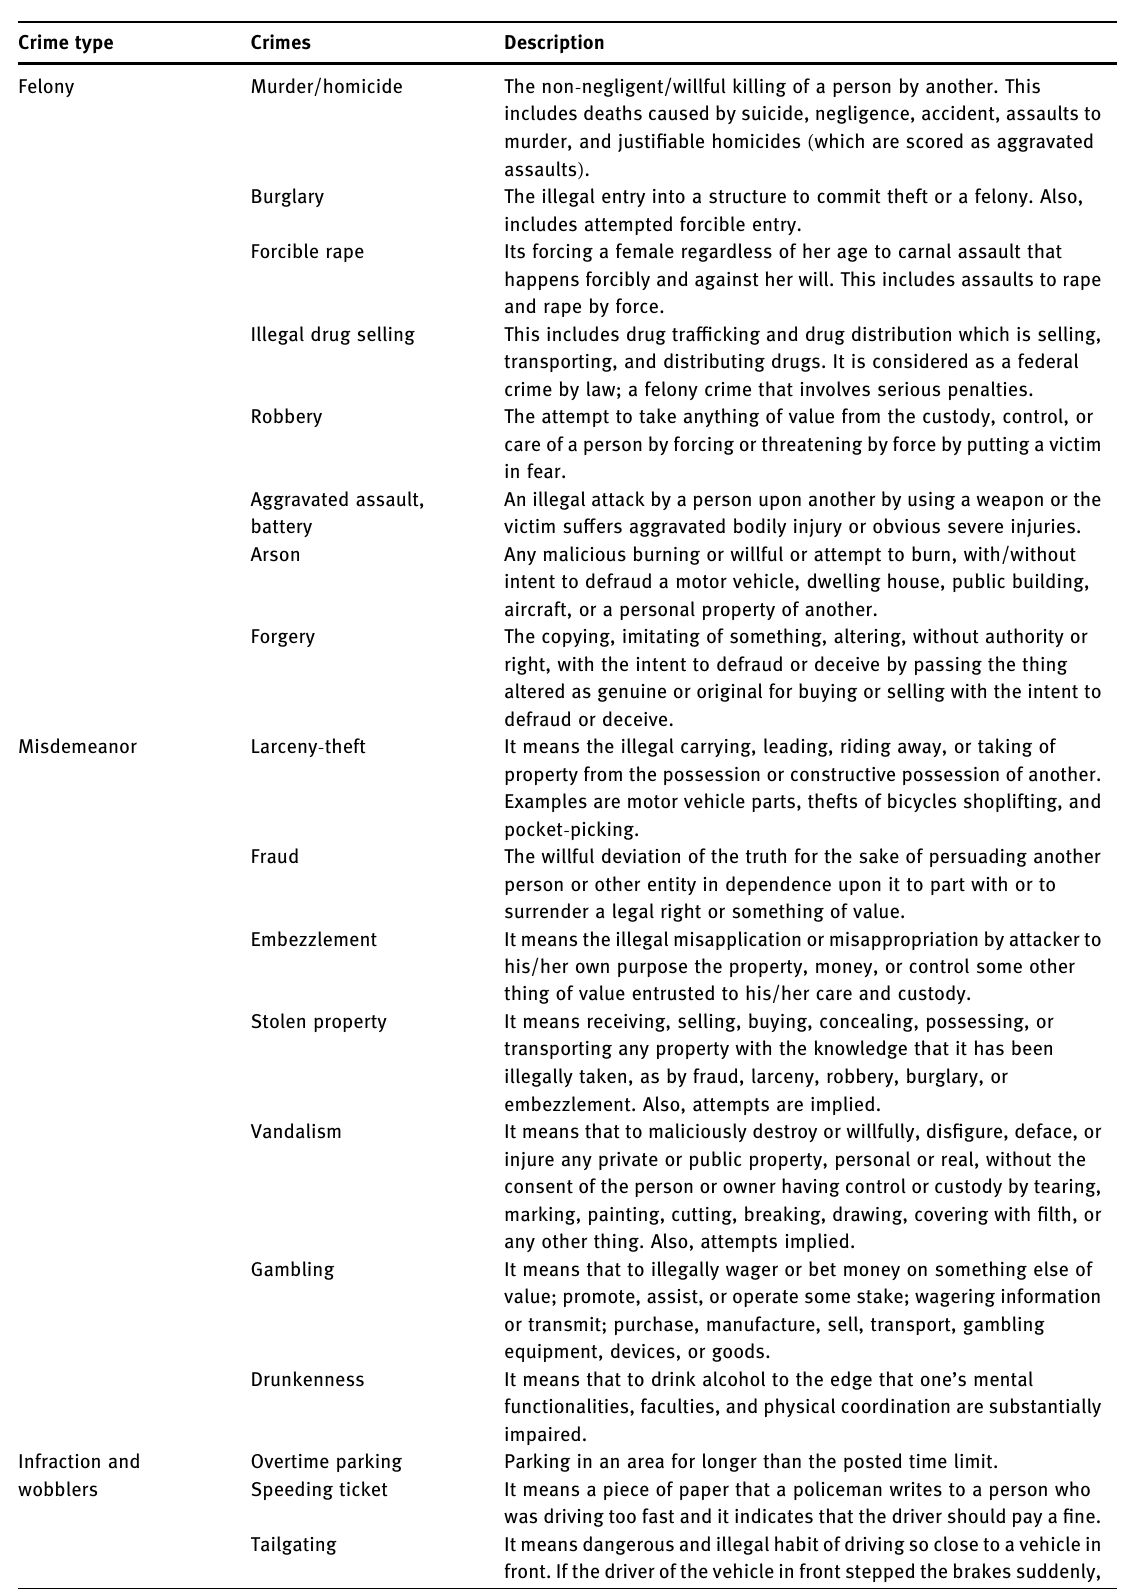
Table 1: Crime description Crime